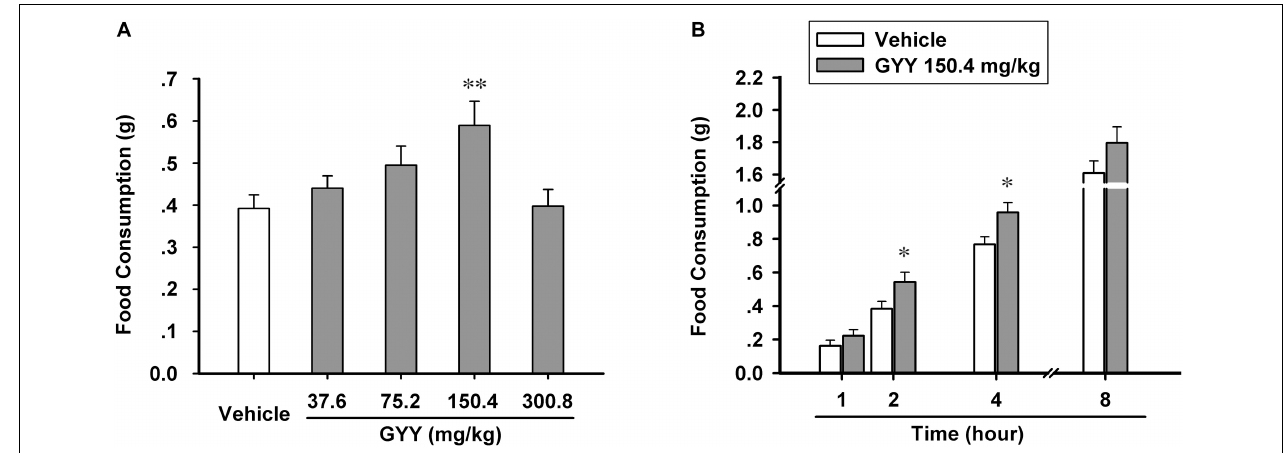
FIGURE 1 | GYY4137 increases food consumption of male C57BL/6J mice. (A) GYY4137 influenced food intake of mice in 2 h after administration via i.p. at different physiological concentrations ( n = 14). (B) GYY4137 at 150.4 mg/kg (400 µ M) promoted food consumption of mice for 4 h after its administration ( n = 8). Data are expressed as means ± SEM. One-way ANOVA and post hoc tests and repeated measures ANOVA were used. ∗ P < 0.05, ∗∗ P < 0.01 vs